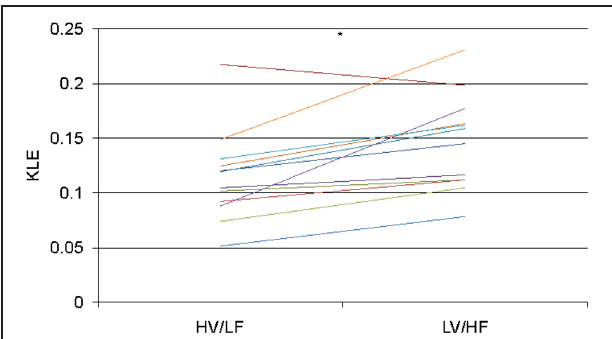
FIGURE 4 | KLE at the time scale of 2.5Hz (0.2s) for each animal during HV/LF versus LV/HF state. Each line color represents a different animal. N = 12, ∗ p = 0 .